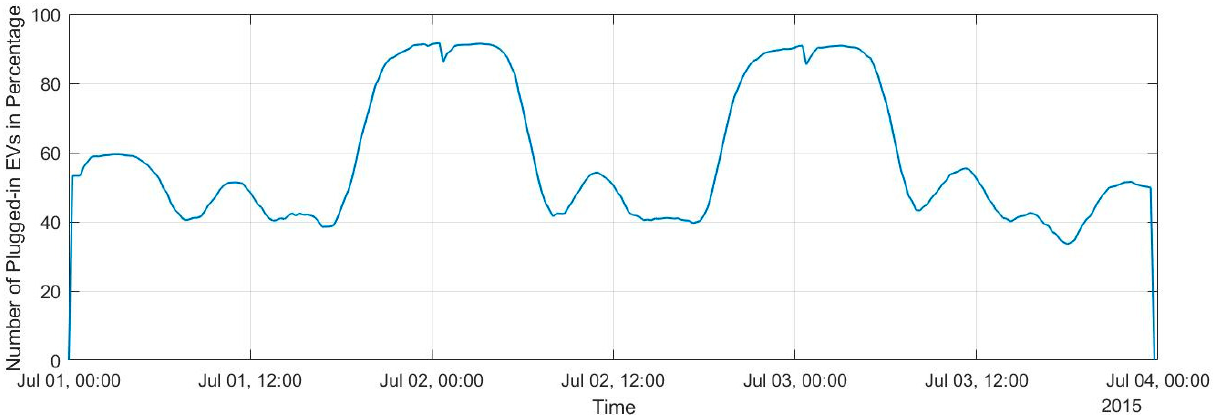
Figure 7. The EVs availability rate.